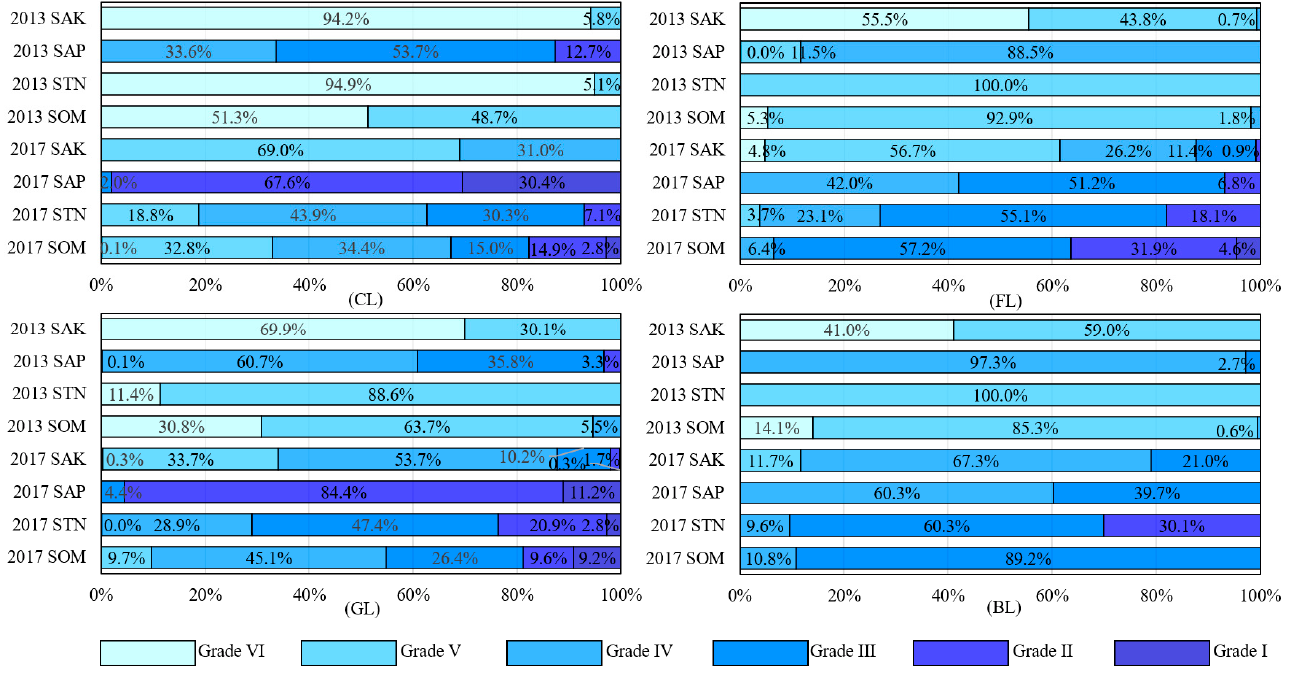
Figure 4. Quantitative structure of soil nutrient grades under different land-use types (CL. Cultivated land; GL. Grassland; FL. Forestland; and BL. Barren land).